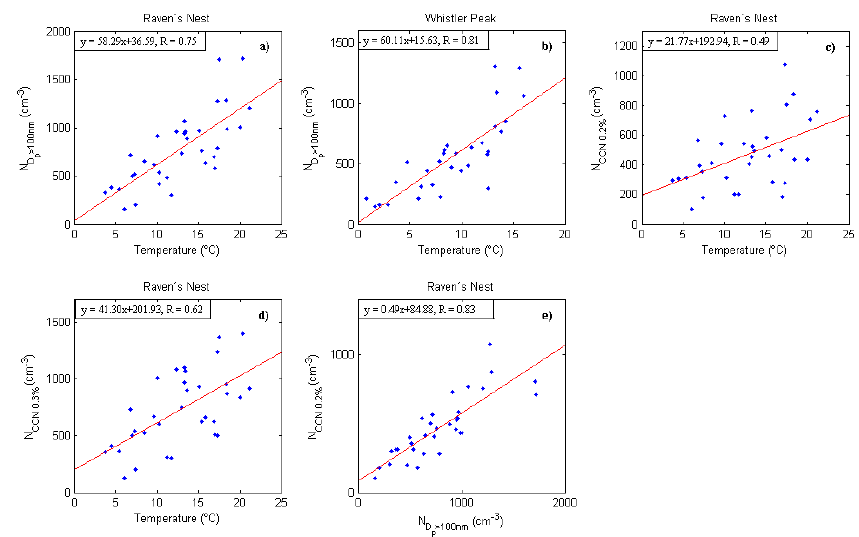
Fig. 10. Temperature dependency for numbers of particles with D p > 100nm at Raven’s Nest (a) and Whistler Peak (b) for numbers of CCN at Raven’s Nest at a supersaturation of 0.2% (c) and 0.3% (d) , and the relation between concentrations of CCN at a supersaturation of 0.2% and particles with D p > 100nm at Raven’s Nest (e) . Each point represents a 24 h average. The red curves represent linear fits according to the given equation in each plot.